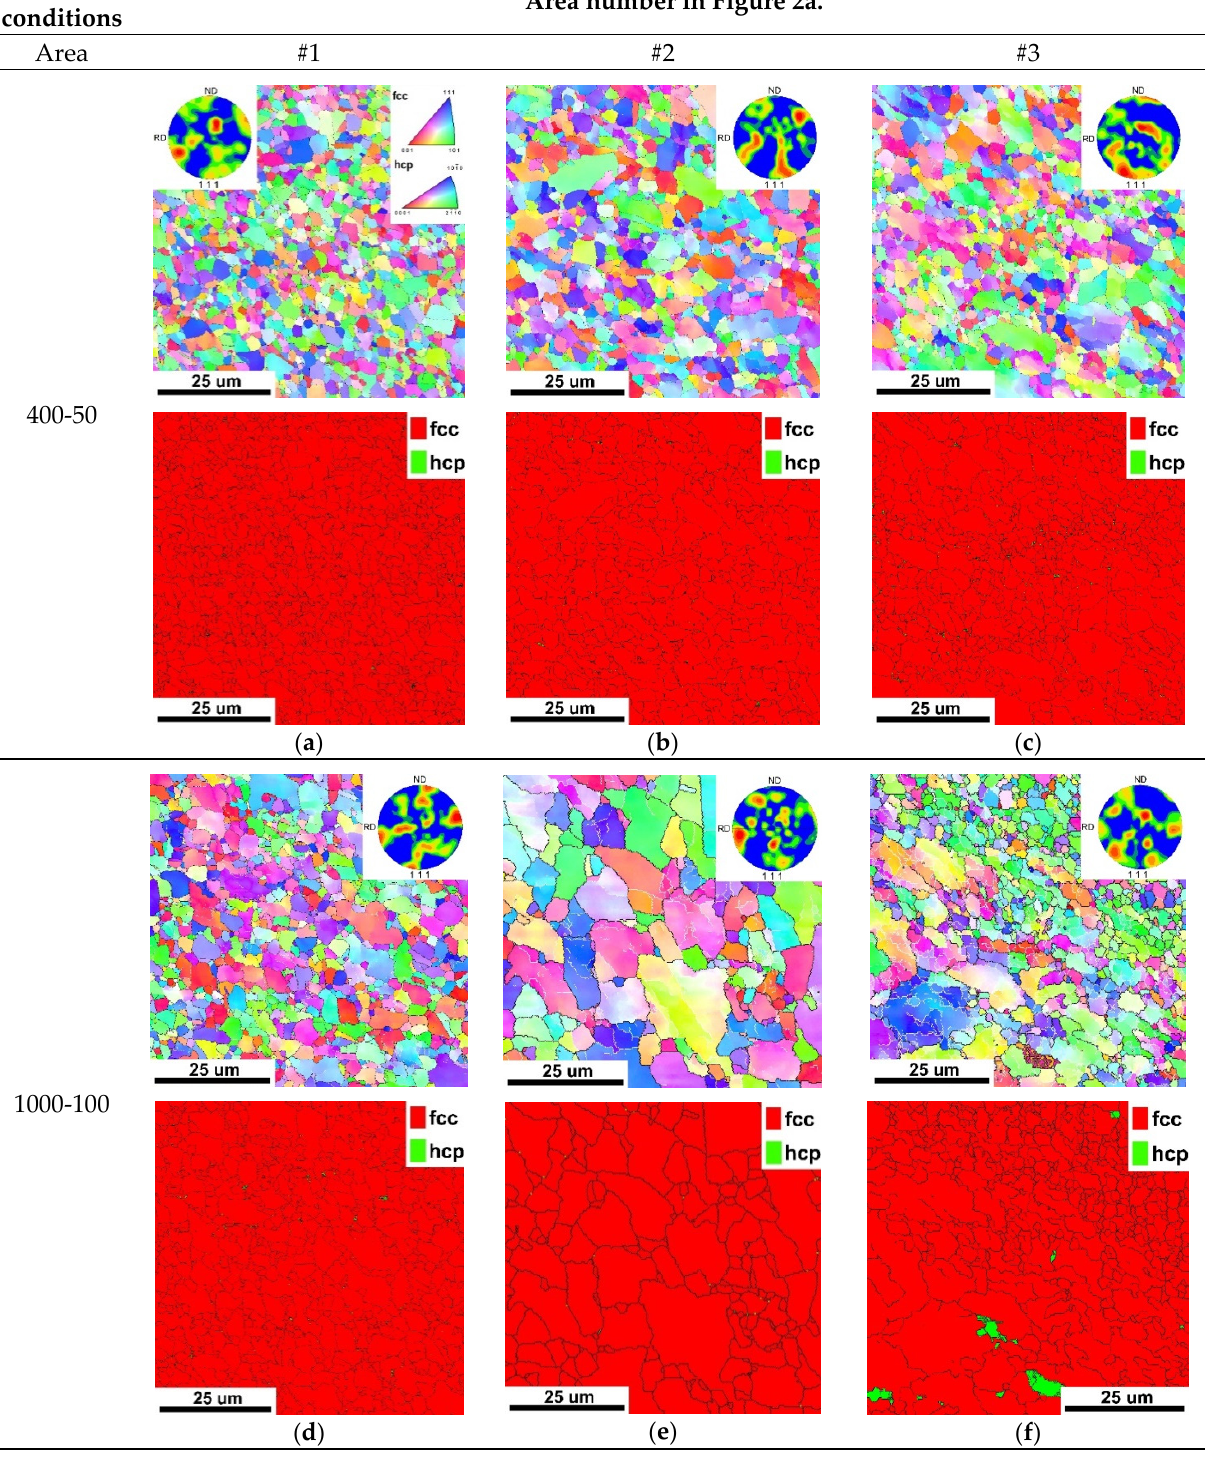
Figure 4. IPF EBSD maps and phase maps of #1 ( a , d ), #2 ( b , e ) and #3 ( c , f ) areas (see Figure 2) of the Fe 49 Mn 30 Co 10 Cr 10 C 1 alloy after FSW: ( a – c ) 400-50; ( d – f ) 1000-100.